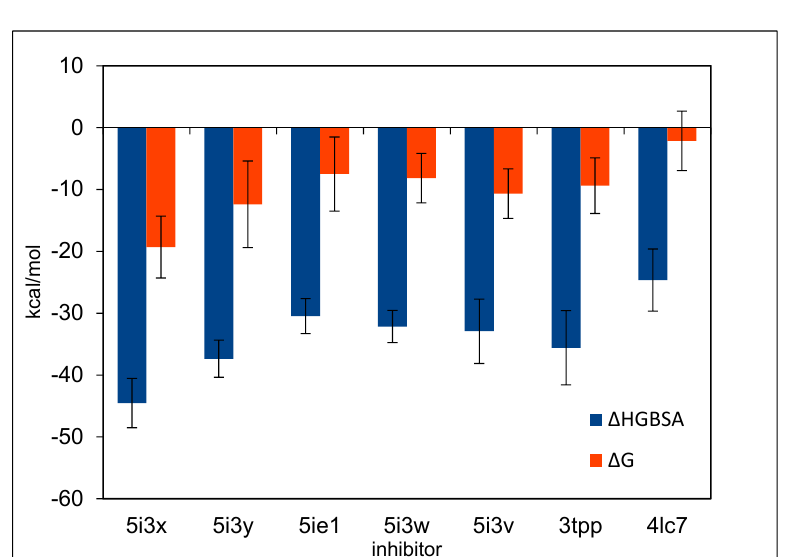
Figure 4. The binding energies of inhibitors calculated by MM/GBSA. Table 2. The different components of binding free energy (kcal/mol) between the inhibitors-BACE1 complex evaluated using the MM/GBSA method.